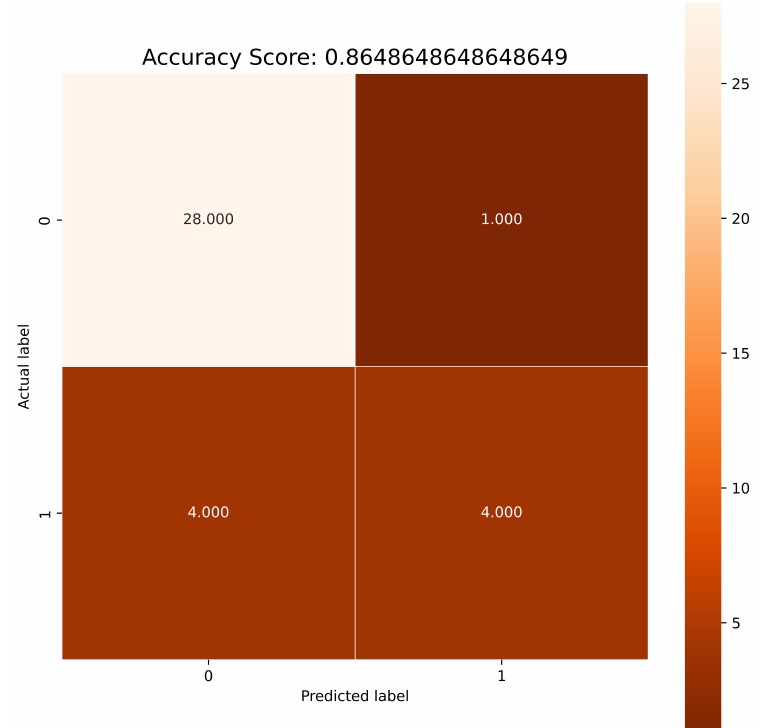
Figure 13. K-NN classifier confusion